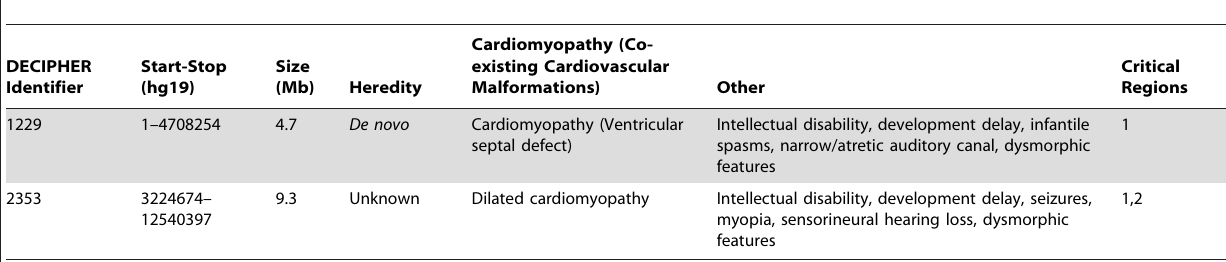
Table 5. Summary of individuals with isolated 1p36 deletions and cardiomyopathy identified from the DECIPHER database.